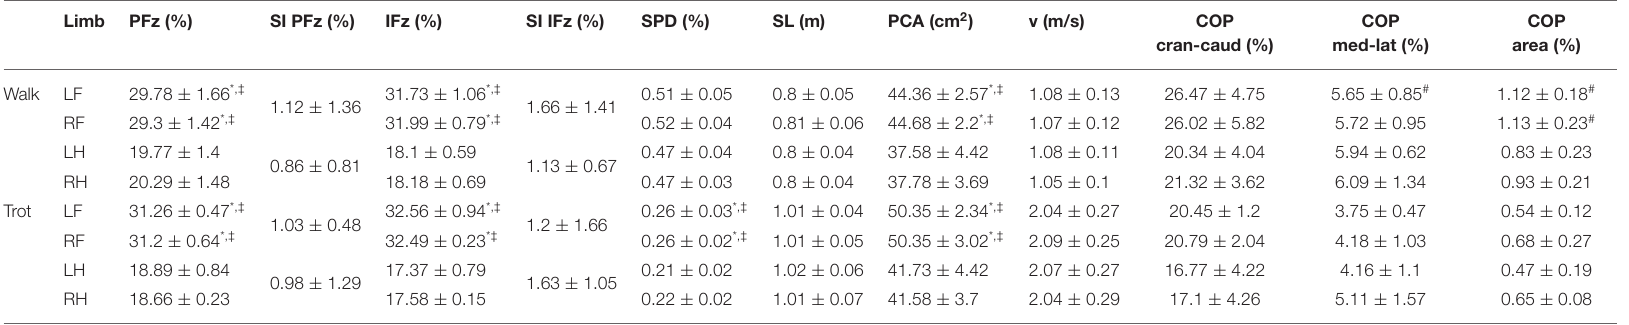
* Indicate a significant difference between the ipsilateral limb pairs; ‡ between diagonal limb pairs; # differences between the control and the boot wearing conditions.